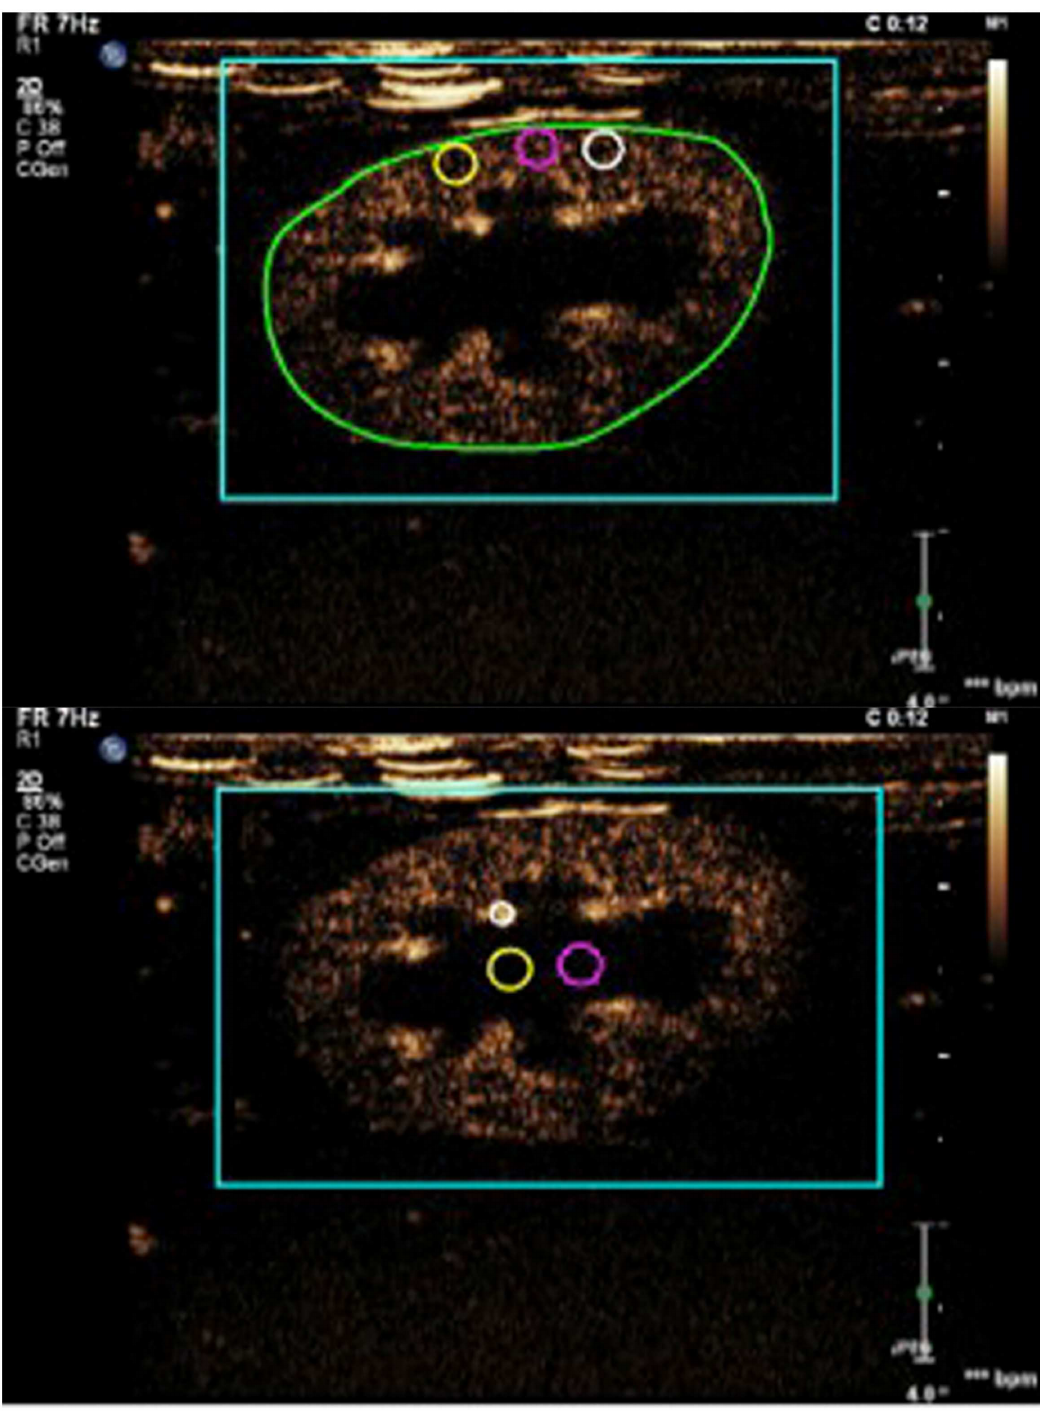
Fig 1. Contrast-enhanced image of the left kidney of a cat. Note the ROIs drawn around the entire kidney, in the renal cortex (top image), renal medullaand centered on an interlobarartery (bottom image).